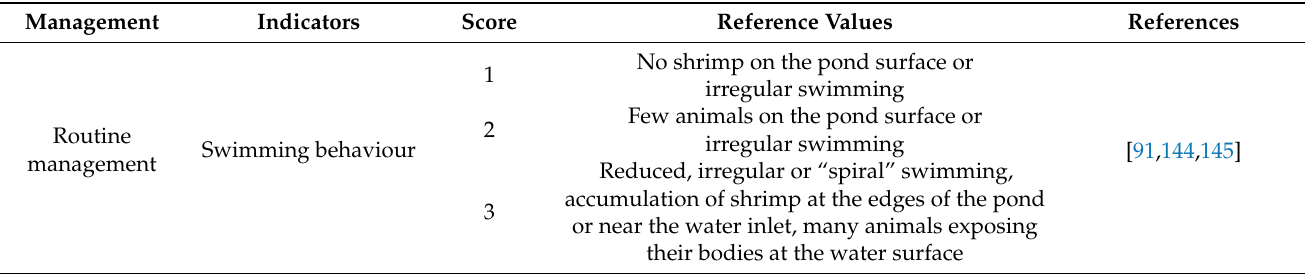
Table 14. Behavioural indicators for Penaeus vannamei juveniles and